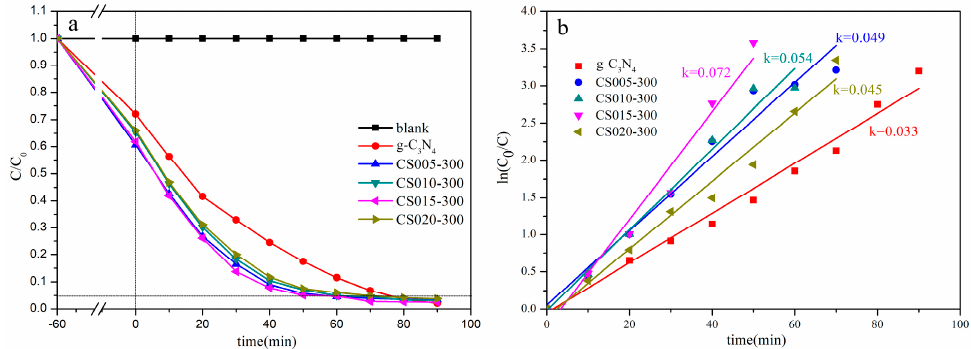
Figure 9. Photocatalytic activities ( a ) and their kinetic constants ( b ) of g-C 3 N 4 , CS005-300, CS010-300, CS015-300, CS020-300.